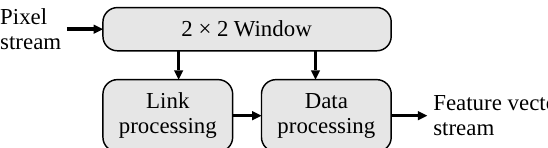
Figure 1. The basic hardware architecture for